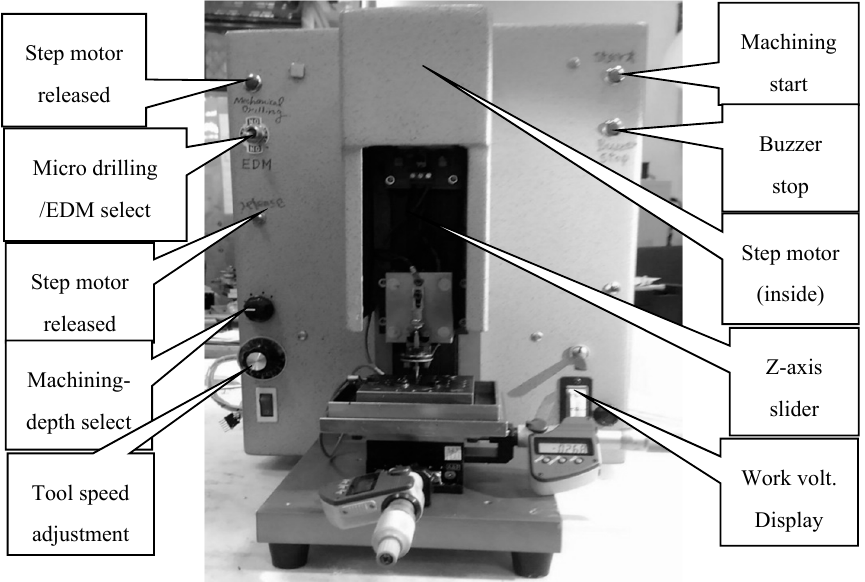
Figure 2. Complete structure of the desktop micro-EDM system.